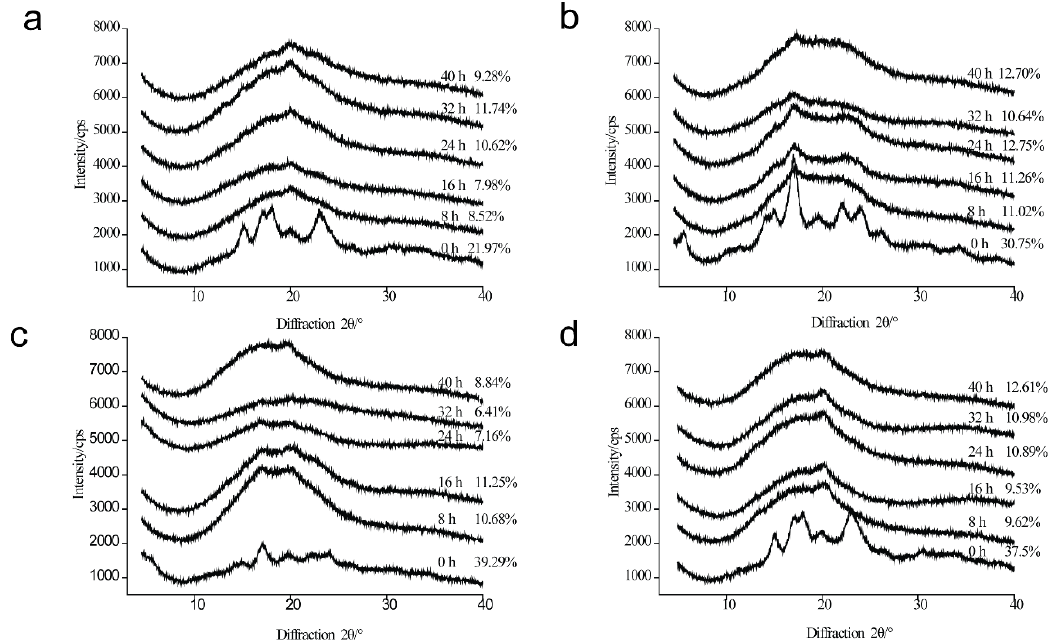
Figure 1. X-ray diffraction (XRD) patterns of native maize starch, potato starch, high-amylose maize starch, and wheat starch (0 h), as well as those during the deep-frying process (8 h, 16 h, 24 h, 32 h, 40 h). ( a ) Maize starch; ( b ) Potato starch; ( c ) High-amylose maize starch; ( d ) Wheat starch.